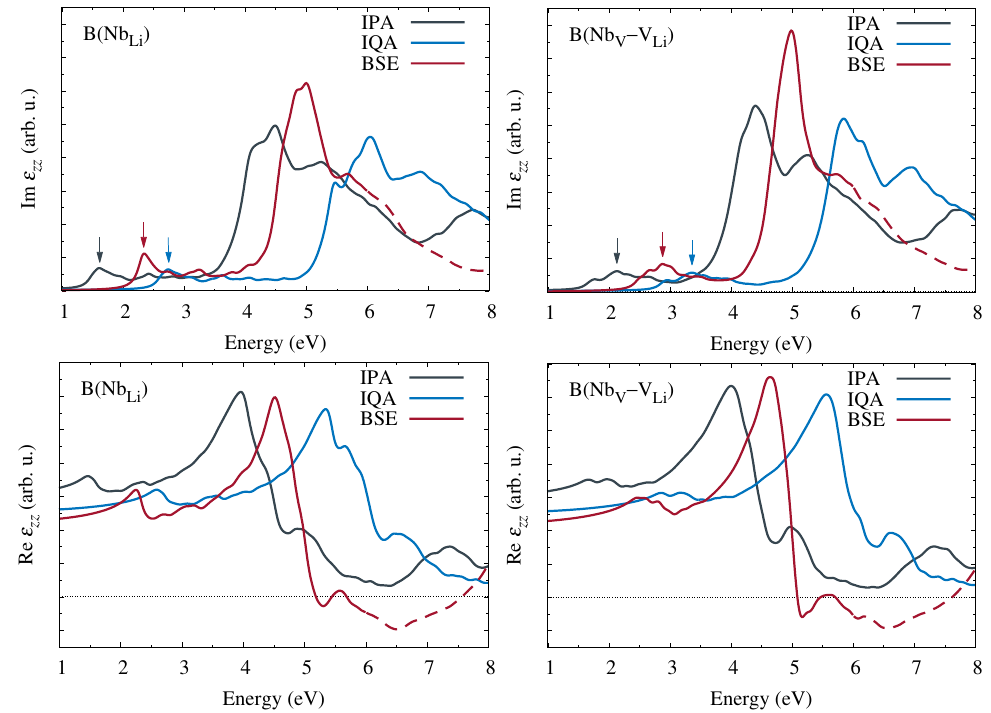
Figure 6. Imaginary ( top ) and real ( bottom ) parts of the ε zz component of the dielectric function for bipolarons localized at a Nb Li antisite defect ( left ) or a Nb V –V Li defect pair ( right ). We compare results from IPA (black), IQA (blue), and BSE (red). The arrows indicate the positions of the dominant defect-related peaks in the absorption spectra. The dashed horizontal line for Re ε zz marks